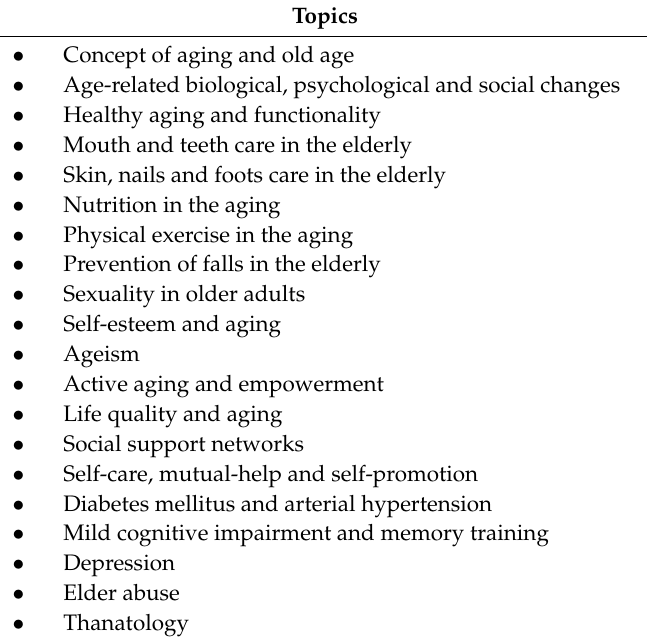
Table 2. Workshop topics revised in the healthy aging program.